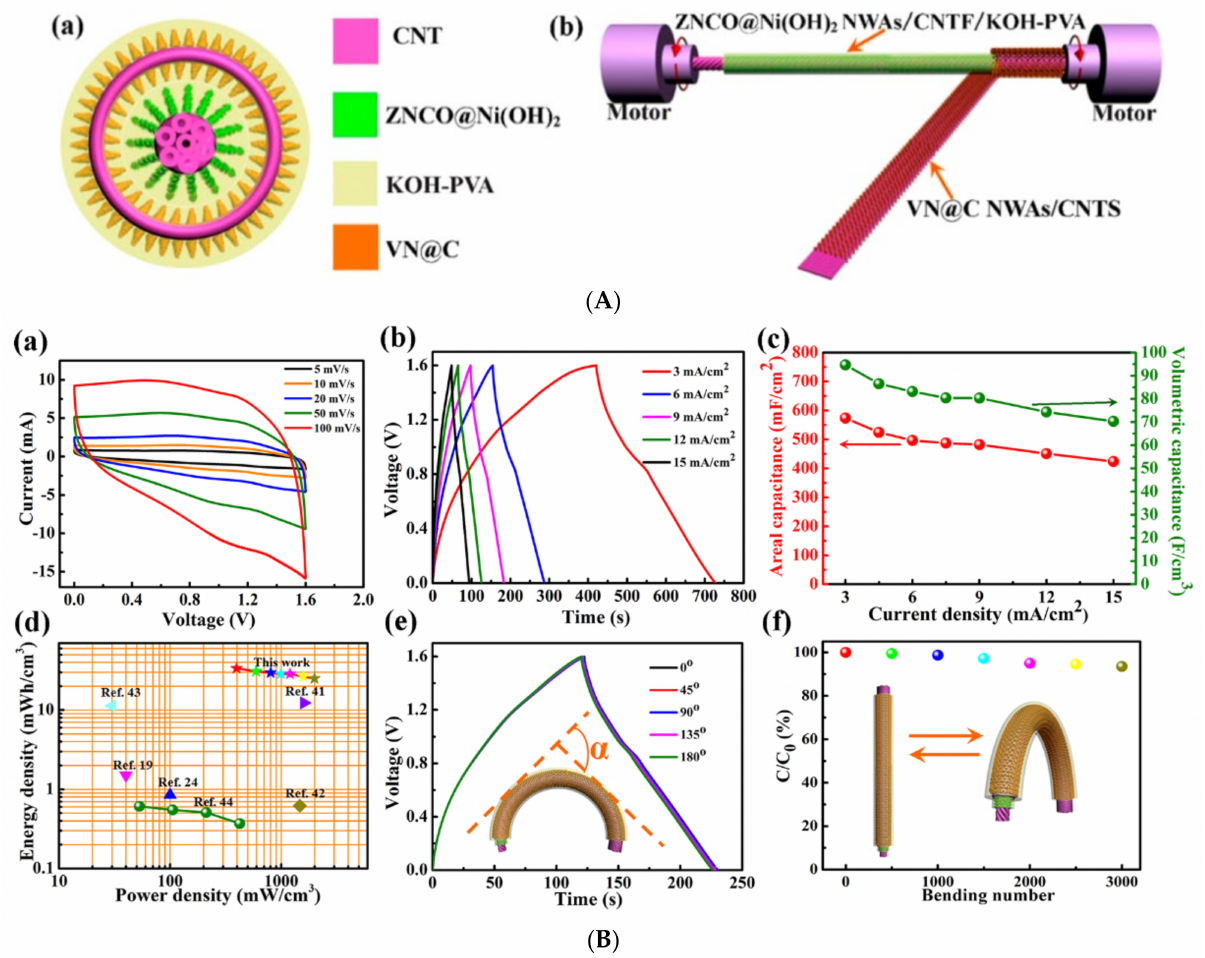
Figure 10. ( A ) ( a ) Cross sectional structure of the CFASCs (coaxial fiber shaped asymmetric super- capacitors). ( b ) Wrapping of the VN@C NWAs/CNTs around the surface of the ZNCO@Ni(OH) 2 NWAs/CNTF/KOH–PVA. ( B ) Electrochemical characterization and flexibility analysis of the as- assembled CFASCs: ( a ) CV curves of the assembled CFASCs measured at different scan rates between 0 and 1.6 V; ( b ) GCD curves collected at different current densities between 0 and 1.6 V; ( c ) areal and volumetric specific capacitances calculated from the GCD curves as a function of the current density; ( d ) volumetric energy and power densities of CFASCs compared with previously reported FASCs (fiber shaped asymmetric supercapacitors); ( e ) GCD curves of the as-assembled CFASCs bent at various angles and a current density of 10 mA/cm 2 ; ( f ) Normalized capacitances of our CFASCs bent 90 ◦ for 3000 cycles. Reproduced with permission from